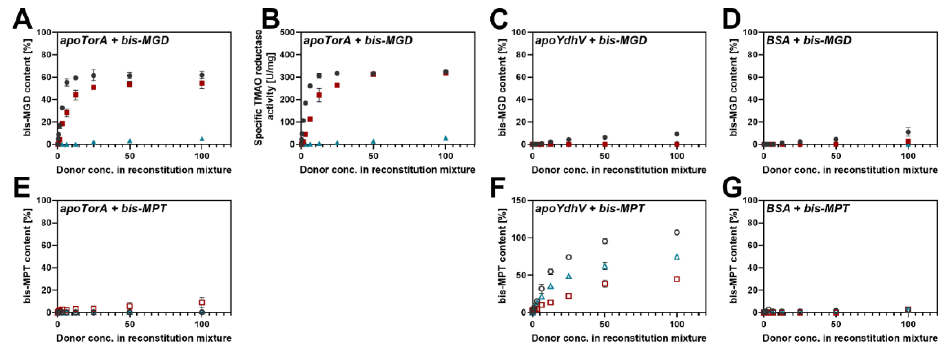
Figure 3. Cofactor binding to apo-TorA, apo-YdhV and BSA. The bis-MGD content of 1.3 µM apo-TorA ( A ), apo-YdhV ( C ) and BSA ( D ) is shown after incubation with bis-MGD from different sources: bis-MGD isolated from wtTorA as donor (circles), bis-MGD formed in vitro out of bis-MPT in a MobA-catalyzed reaction (squares), residual bis-MGD after conversion into bis-MPT in a PD-catalyzed reaction (triangles). Bis-MGD was detected in form of its fluorescent oxidation product FormA-GMP. Panel ( B ) represents the specific TMAO reductase activity of the samples in panel A. The bis-Mo-MPT content of 1.3 µM apo-TorA ( E ), apo-YdhV ( F ) and BSA ( G ) is shown after incubation with bis-Mo-MPT from different sources: bis-Mo-MPT isolated from YdhV as donor (circles), residual bis-Mo-MPT after conversion into bis-MGD in a MobA-catalyzed reaction (squares), bis-Mo-MPT formed in vitro out of bis-MGD in a PD-catalyzed reaction (triangles). Bis-Mo-MPT was detected in form of its fluorescent oxidation product dephospho-FormA. No TMAO reductase activity was detected for these samples.